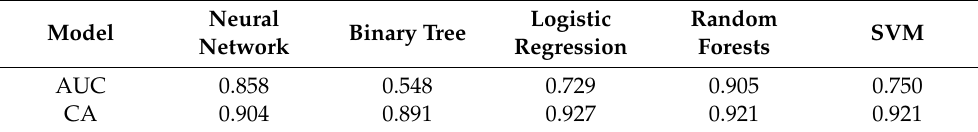
Table 15. Models accuracy metrics for add_to_cart_indirect as target parameter.